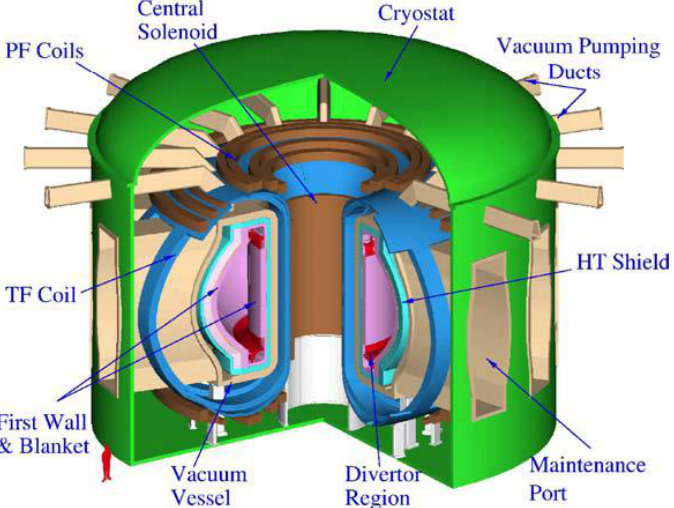
Figure 1. The ARIES-AT fusion power core, reprinted with permission from Ref. [15]. The materials of first wall suffer strong neutron flux.